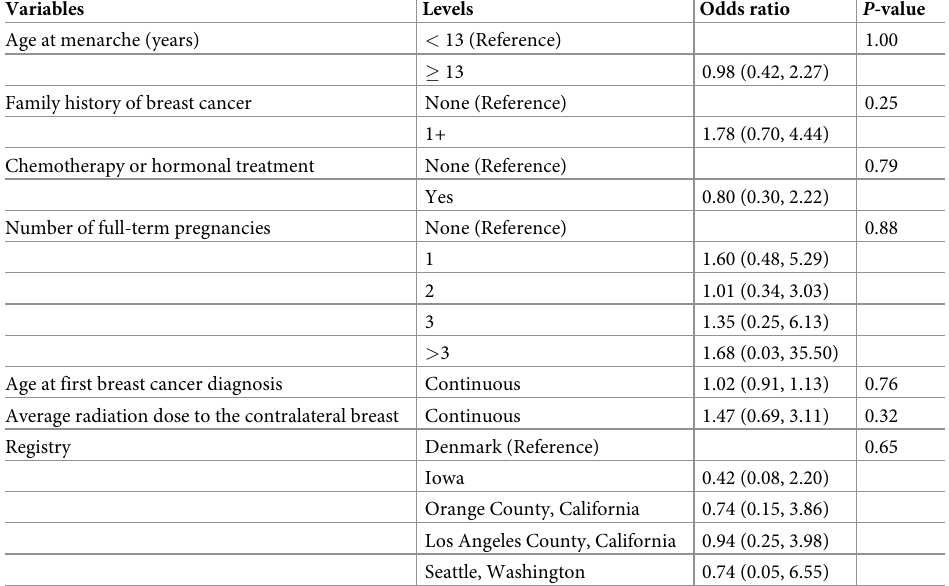
Table 2. Statistical significance of associations between radiation-associated contralateral breast cancer and clini- cal variables in the training dataset of the study cohort. Numbers in parentheses: 95% confidence intervals for odds